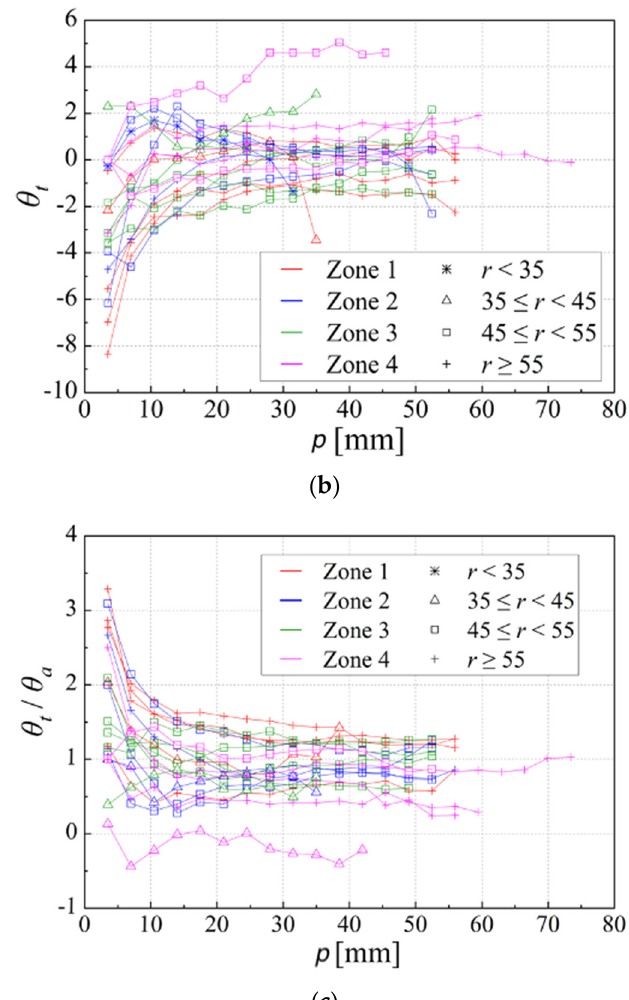
Figure 8. Mean luminescent mini-tuft angle varies on different positions of tuft. ( a ) θ a = 4°; ( b ) θ a = 0°; ( c ) θ a = − 4°.